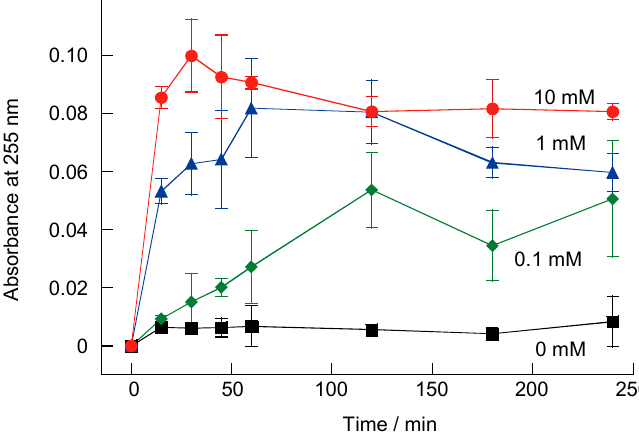
Figure 10. Optical microscopy ( a ) and fluorescence microscopy (( b ), excitation: 488 nm) and (( c ) excitation: 543 nm) images of PAH/GOx/(SA-PAH/PBA-PAH) 5 film-coated CaCO 3 microparticles in which PBA-PAH and GOx have been labeled with FITC and TRITC, respectively. The scale bar is 5 μ m.